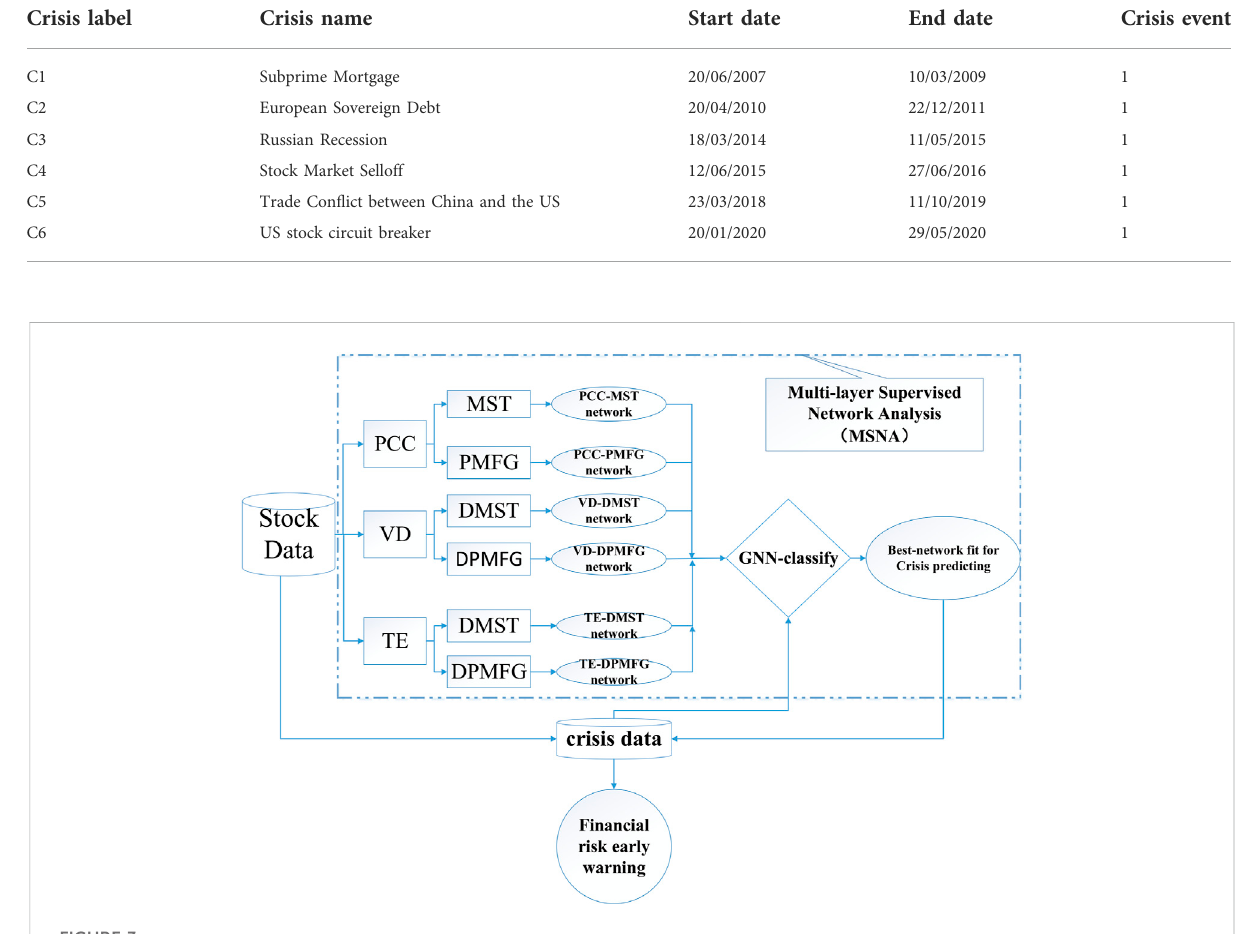
TABLE 1 The table of crisis events.